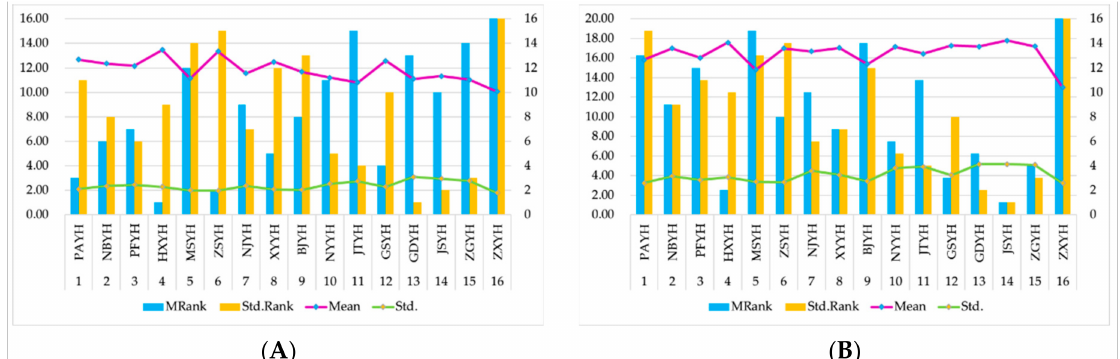
Figure 10. The results of the mean and standard deviations of ∆ CoVaR (In the figure, we calculate the daily ∆ CoVaR (the di ff erence between the Conditional Value at Risk (CoVaRs) when the bank is in distress and in a normal state) of each bank, and then derive the corresponding mean and standard deviation for each bank): ( A ) 2017; ( B ) 2018.